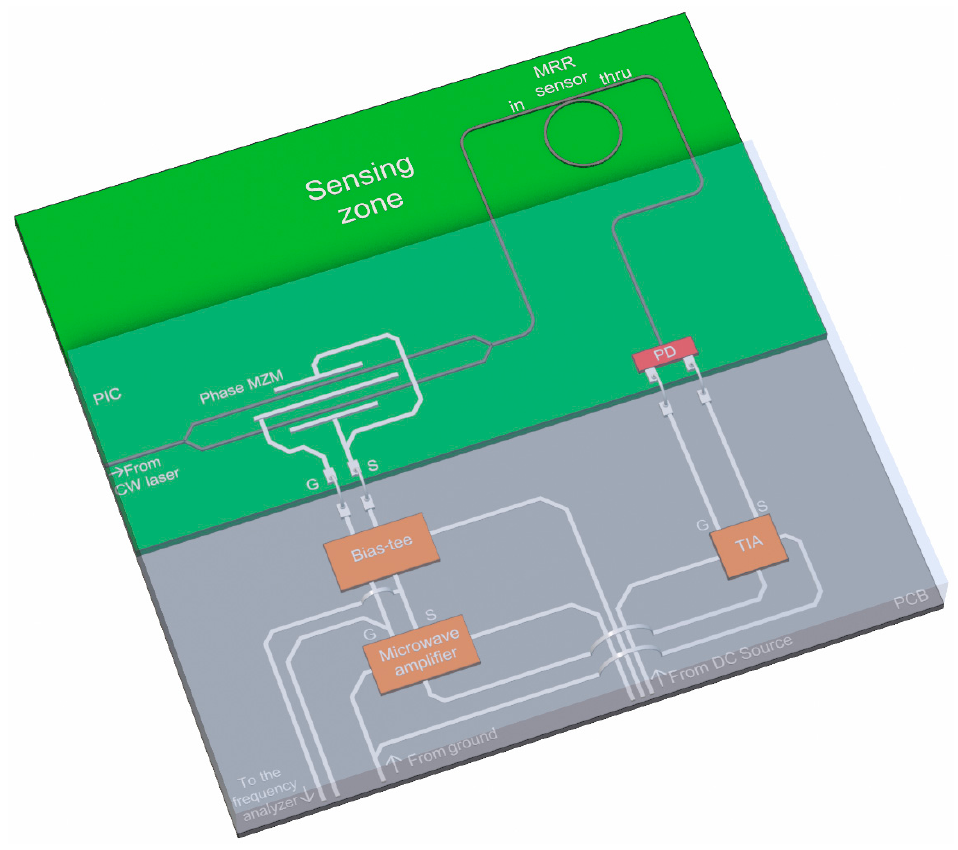
Figure 1. Sensing system structure and layout (not to scale).